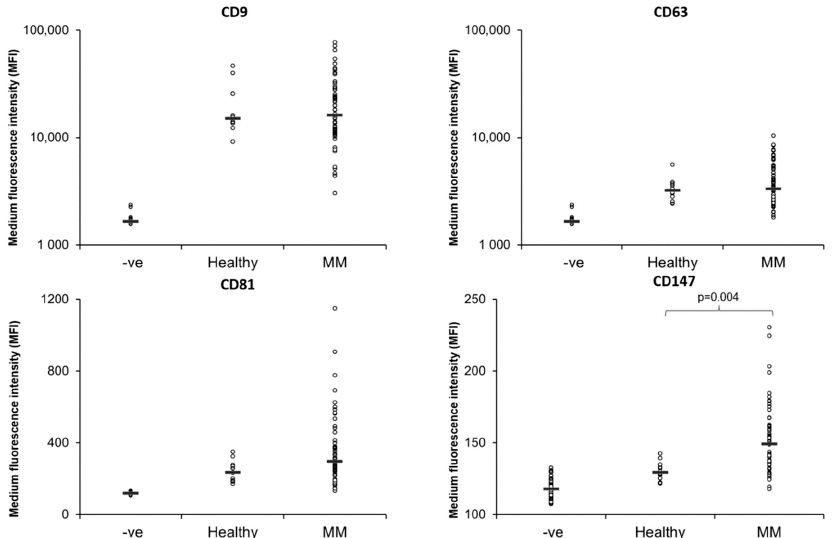
Figure 1. Healthy and Multiple Myeloma peripheral blood EVs are positive for EV markers; CD9, CD63, CD81 and CD147. 1.25 × 10 7 EVs/test from 61 MM patients and 12 healthy controls were bound to the surface of 4 µ m aldehyde/sulfate latex beads and stained with antibodies for the EV markers; CD9, CD63, CD81 and CD147 for 30 min on ice. The samples were then resuspended in 200 µ L PBS and flow cytometry analysis was performed on a CytoFLEX LX Flow Cytometer. Gating of EV-decorated 4 µ m in diameter beads was performed based on FCS/SSC parameters, so that unbound EVs or possible antibody aggregates are excluded from the analysis.